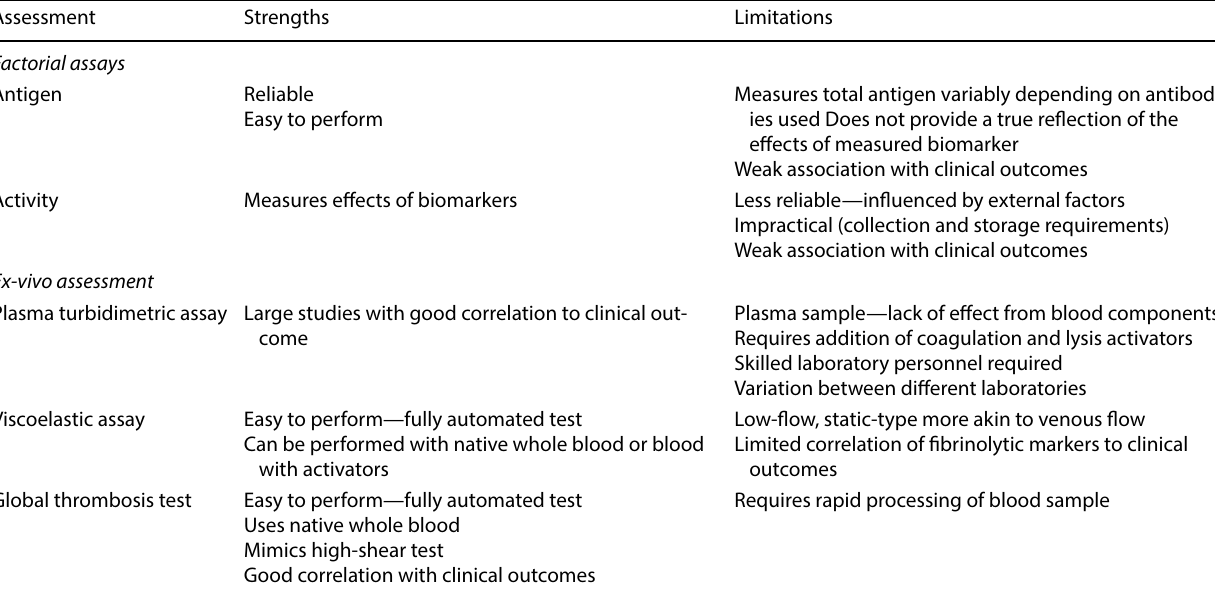
Table 1 Summary of strengths and limitations of different assessment